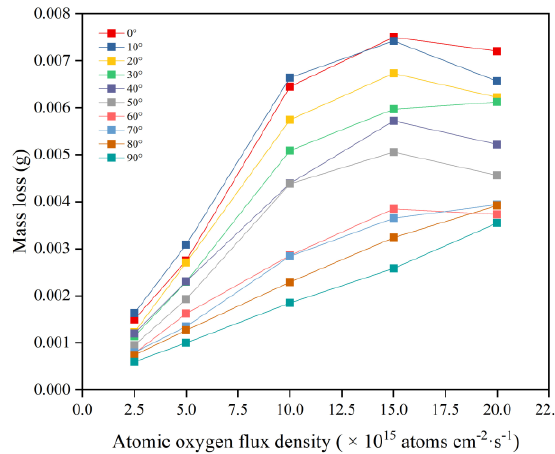
Figure 3. Mass loss of Kapton films at different flux densities and incidence angles.